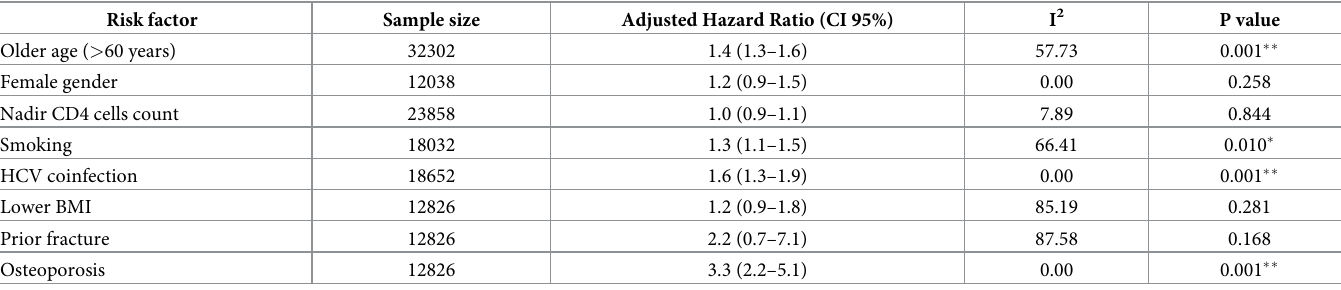
Table 4. Risk factor of fractures among people living with HIV.